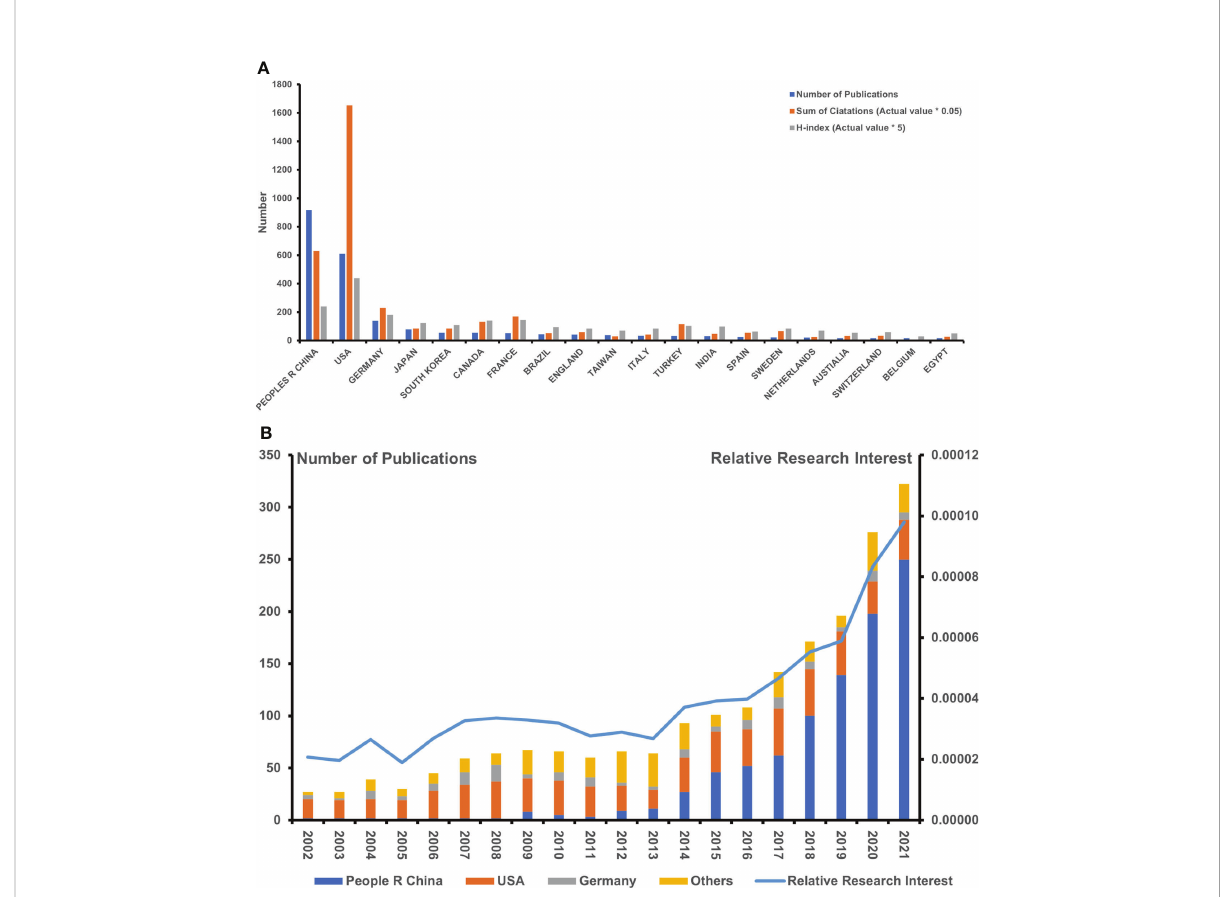
FIGURE 2 Achievement of various countries/regions in the research fi eld regarding sepsis and programmed cell death. (A) The published number, summary citation frequency (×0.05), and H-index (×5) in the top 20 countries. (B) The published number globally and in the top 3 countries each year, and the timeline of relative research interest of sepsis and programmed cell death (*means